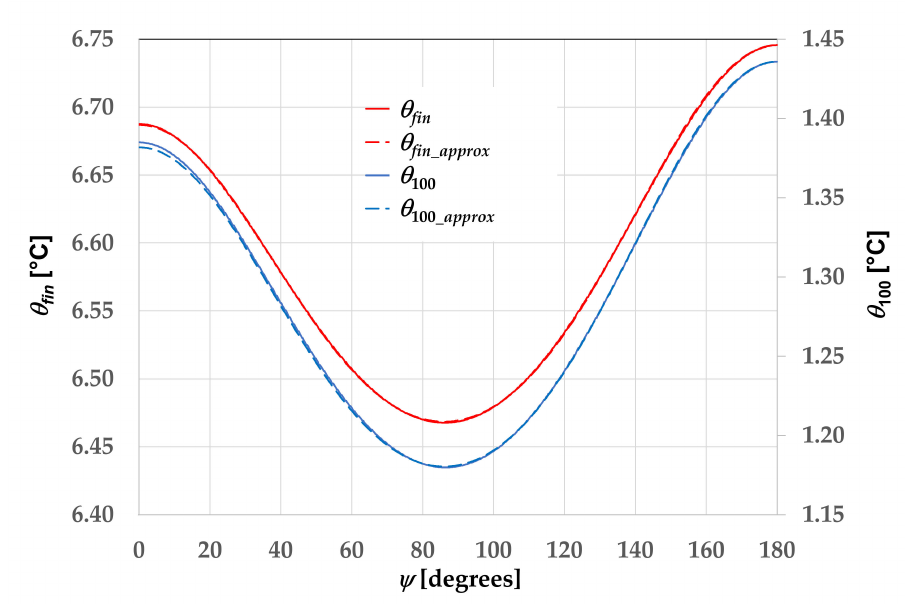
Figure 8. Diagrams of the temperature rise along the upper part of the aluminum-tube surface, for t = 3106 min and t = 100 min, obtained by a 2D simulation ( θ fin and θ 100 ), and by applying Equation (6) ( θ fin_approx and θ 100_approx ).